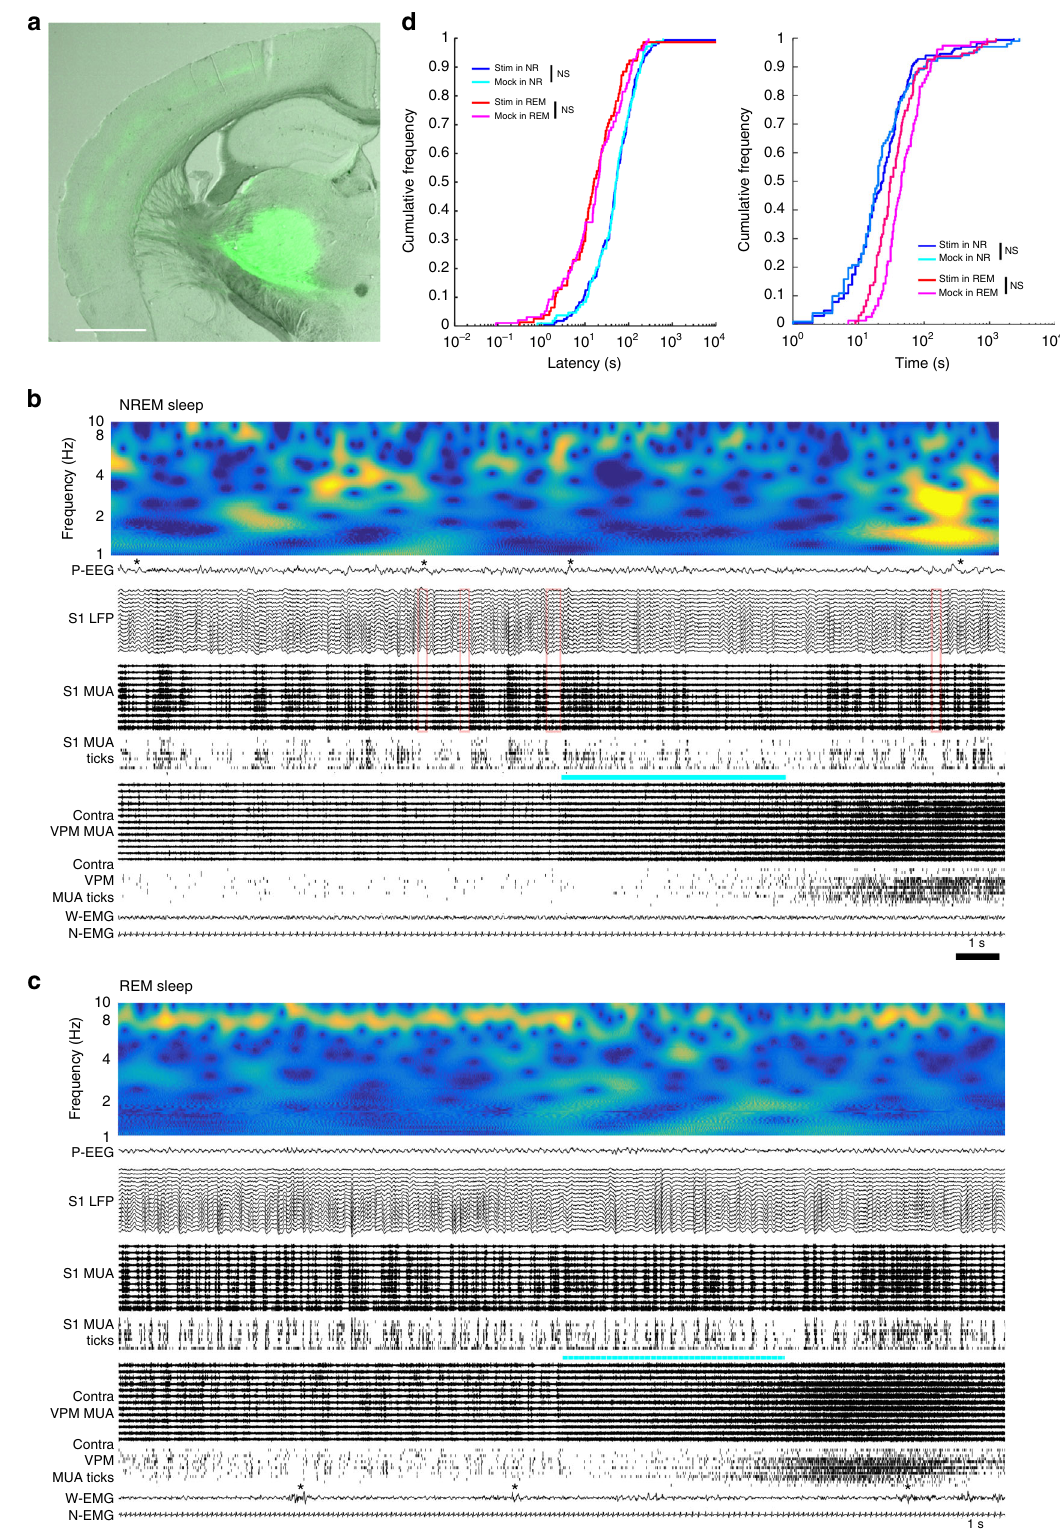
with an automatic method to quantify motor activity (whisker EMG), using the 10 s before stimulation onset as baseline EMG values. In all mice, including the one in which overt limb movements were not seen, the established EMG threshold (>mean + 10 std of baseline) was reached faster after VM